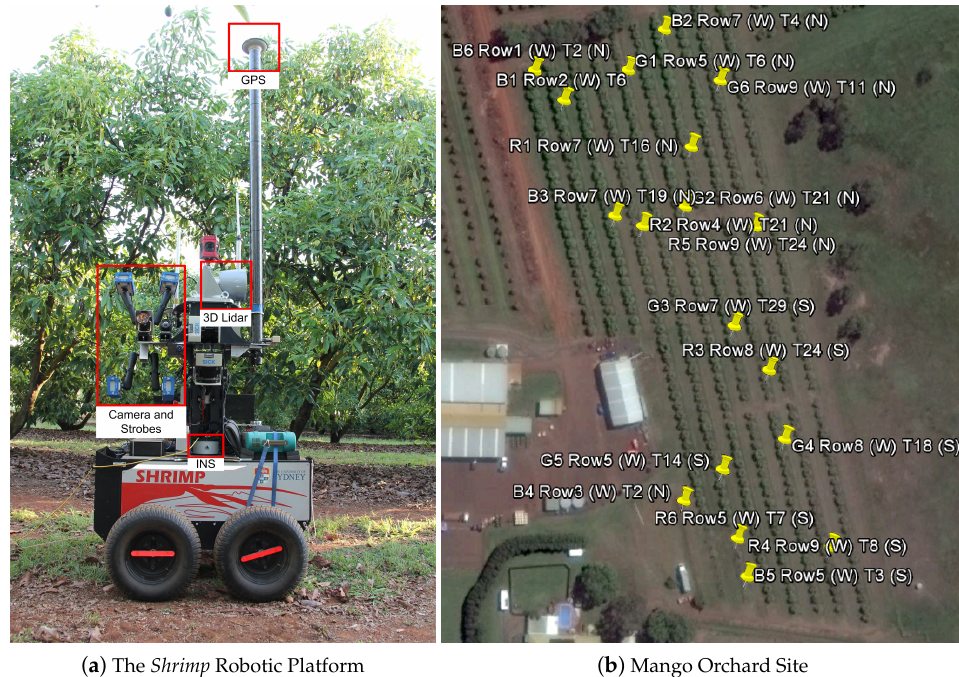
Figure 2. The robotic platform Shrimp ( a ) with labels to indicate the locations of the sensors used in this paper; a map of the mango orchard test block ( b ), with yellow pins marking the 18 trees that were selected for ground-truth field and harvest fruit